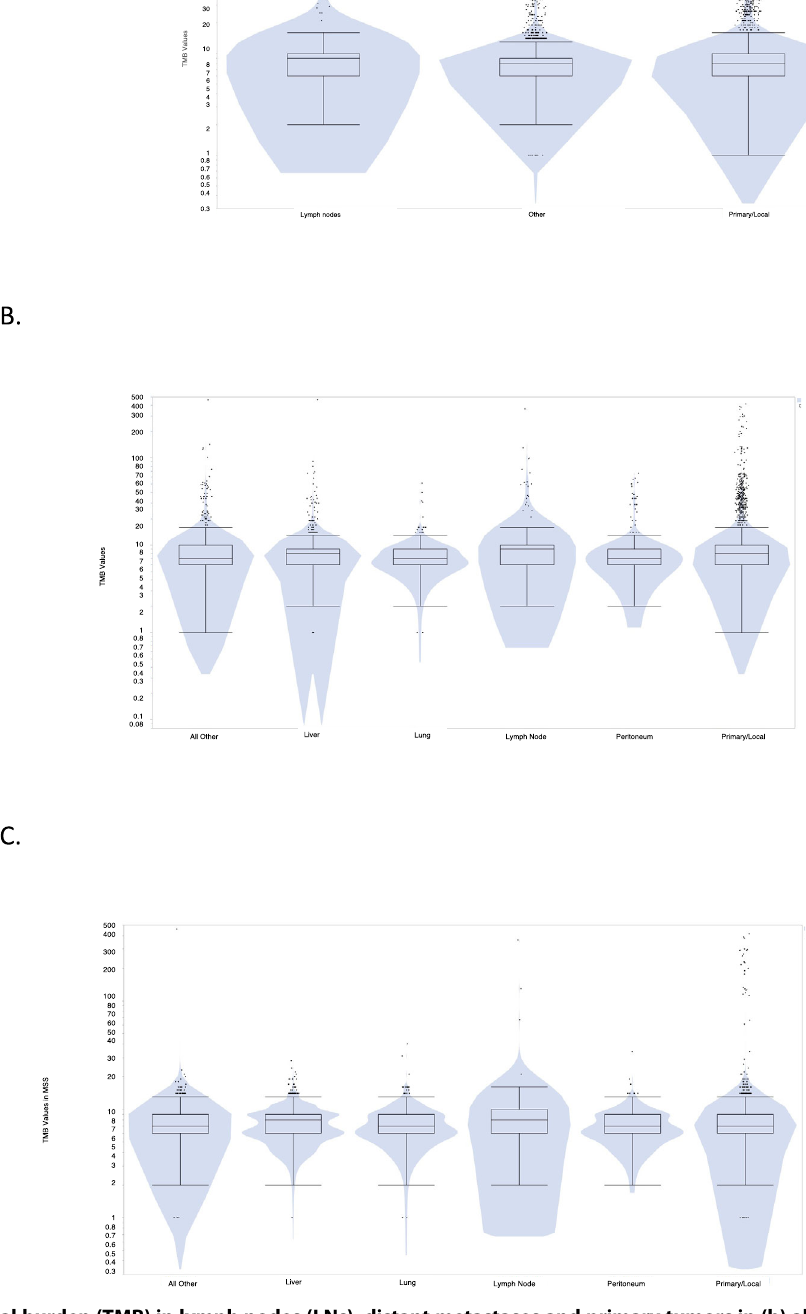
Fig. 4 Tumor mutational burden (TMB) in lymph nodes (LNs), distant metastases and primary tumors in (b) all tumors and in (c) MSS only tumors. A Comparison of TMB in LNs (median TMB = 9), distant metastases (median TMB = 8) and colorectal primary tumors (median TMB = 8, P = 0.0052 by Kruskal – Wallis). B Comparison of TMBs with distant metastases further categorized into all distant metastases (median TMB = 7), liver (median TMB = 8), lung (median TMB = 7), LNs (median 17 TMB = 9), peritoneal (median TMB = 7), primary (median TMB = 8) ( P = 0.0107 by Kruskal – Wallis). C Same categorization in microsatellite stable (MSS) tumors only: all distant metastases (median TMB = 7), liver (median TMB = 8), lung (median TMB = 7), LNs (median TMB = 8), peritoneal (median TMB = 7), primary (median TMB = 7) ( P = 0.0001 by Kruskal –